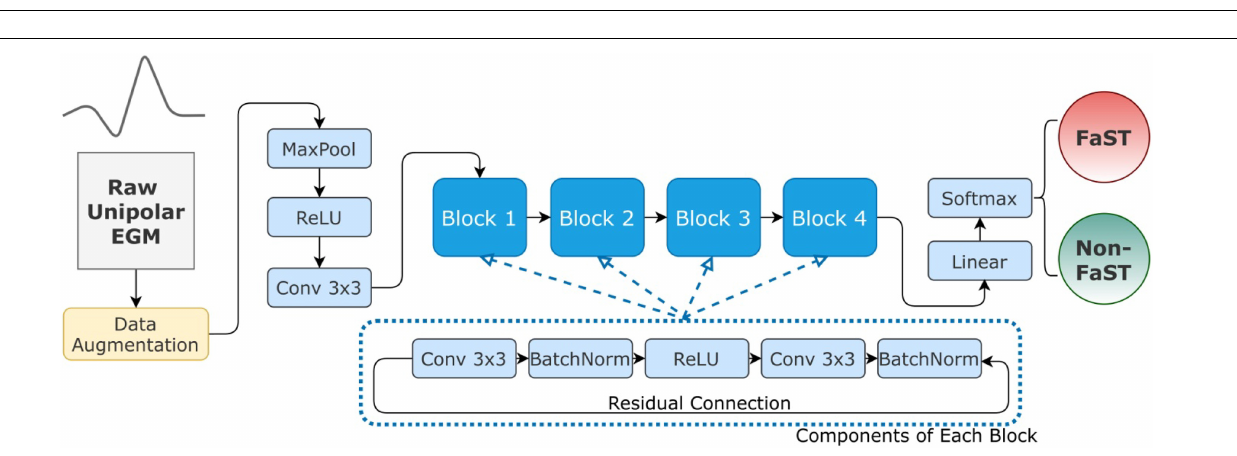
FIGURE 1 | FaST Algorithm. (A) Hierarchical steps in FaST classification. (B) Representative examples of bipolar and unipolar EGMs from three different left atrial sites. In each example, the power spectral plot of the bipolar EGM indicates the presence of periodicity (i.e., spectral peak above threshold red horizontal line). The periodicity cycle length is calculated from the spectral peak (right panels). The first two examples are classified as FaST sites by the FaST algorithm based on the presence of bipolar EGM periodicity and sustained unipolar QS complexes for the duration of the 5-s recording. The top example shows discrete bipolar EGM complexes while the bottom example also contains complex, fractionated bipolar EGM complexes. In contrast, the third example is classified as No FaST because the unipolar EGM does not manifest sustained QS complexes for the duration of the 5-s recording, even though there is bipolar EGM periodicity. The first 1.4 s of the unipolar EGM manifests RS complexes, followed by QS complexes.